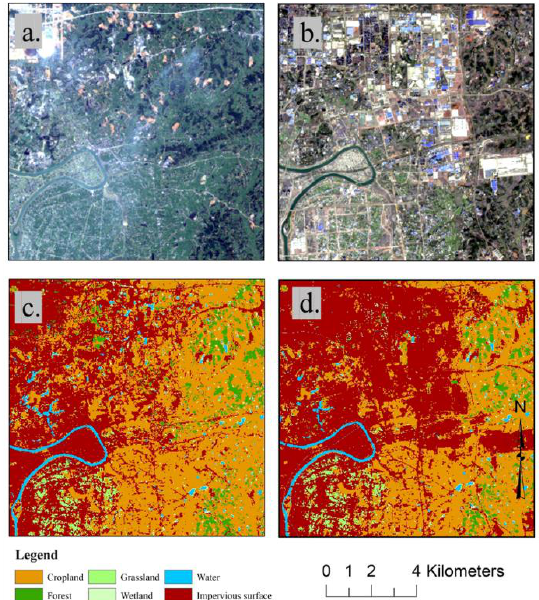
Figure 3. Example of the CZTUA LULC change between the year of 2001 and 2017: ( a ) the high- technology development zone in Changsha County 28 June 2001 Landsat image with true color; ( b ) a Landsat image with true color 17 December 2017; ( c ) the Continuous Change Detection and Classification (CCDC) LULC map contemporaneous with (a); and ( d ) the CCDC LULC map contemporaneous with (b). Table 2. Results of the spatiotemporal accuracy assessment for the CCDC.